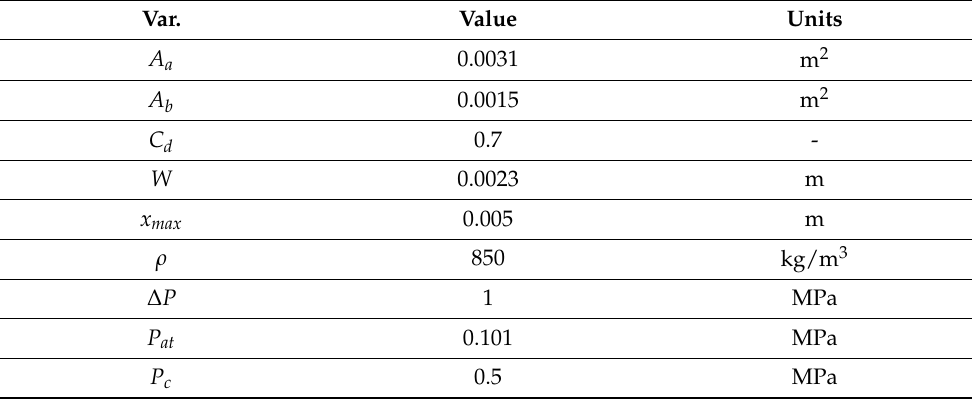
Table 1. The constant parameters of the two systems. Var. Value Units A a 0.0031